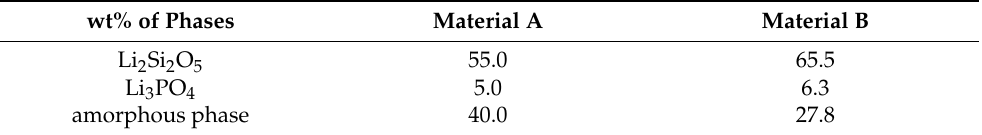
Table 3. Phase composition of material A and B determined by the Rietveld analysis. wt% of Phases